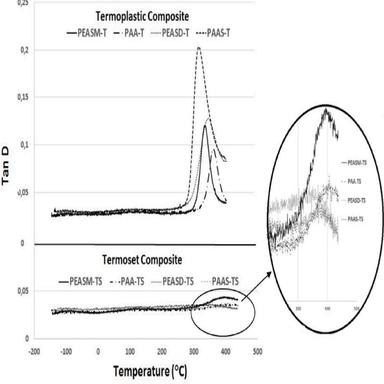
The Tan D curves of the advanced composites.